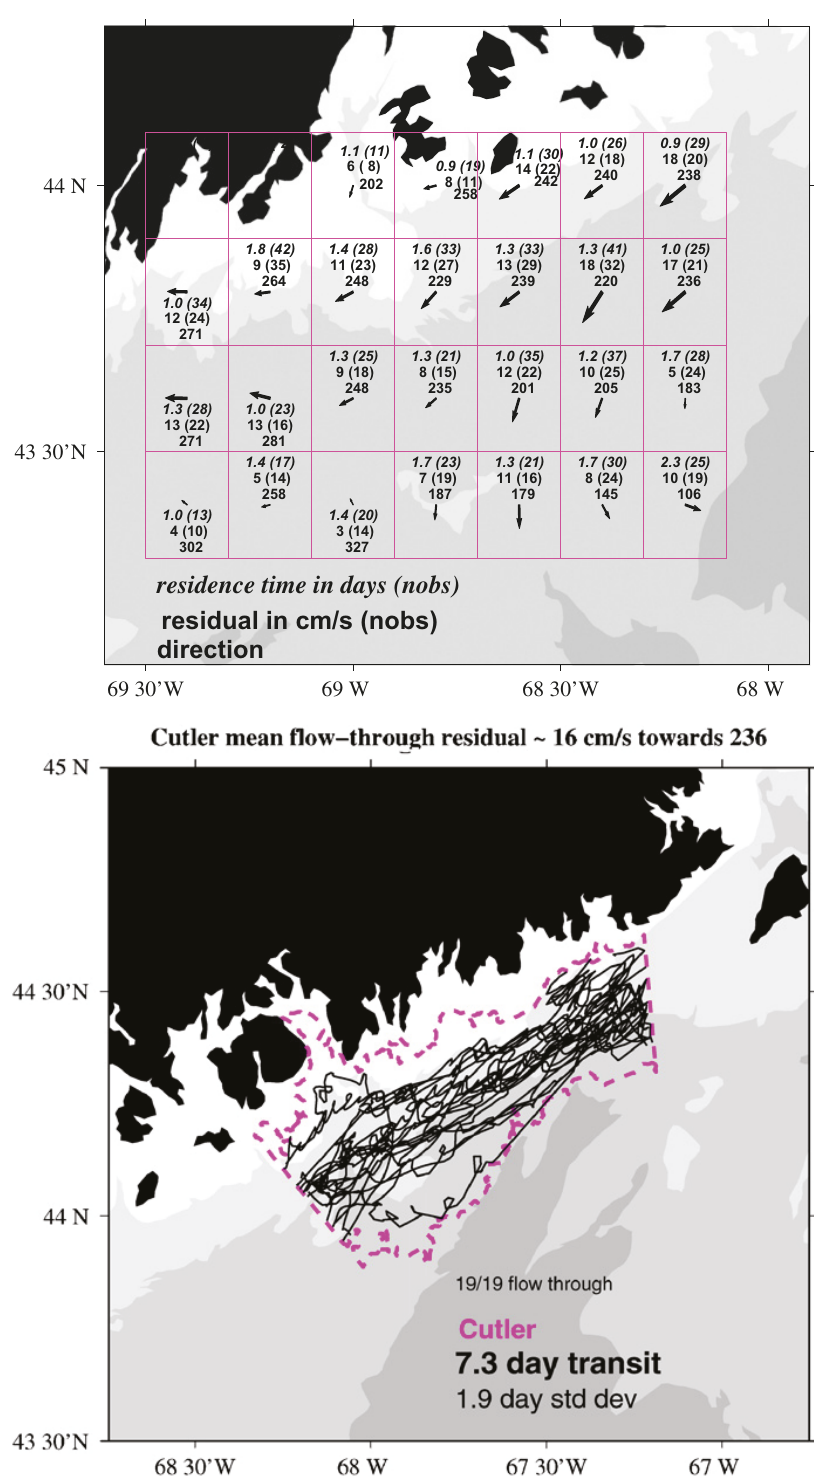
Figure 7. Results from the drifter field studies of Manning et al. [103] in the Gulf of Maine. Upper Panel: calculated residence times in days (italics), low frequency speed in cm / s, and direction in degrees True. Number of observations (“nobs”) is in parentheses. Lower Panel: tracks of drifters entering waters o ff shore Cutler Maine from the northeast and heading southwest in the Eastern Maine Coastal Current. Transit time (7.3 d) is the mean time for drifters to traverse the region outlined in purple. (Modified from Manning et al. [103], with permission from